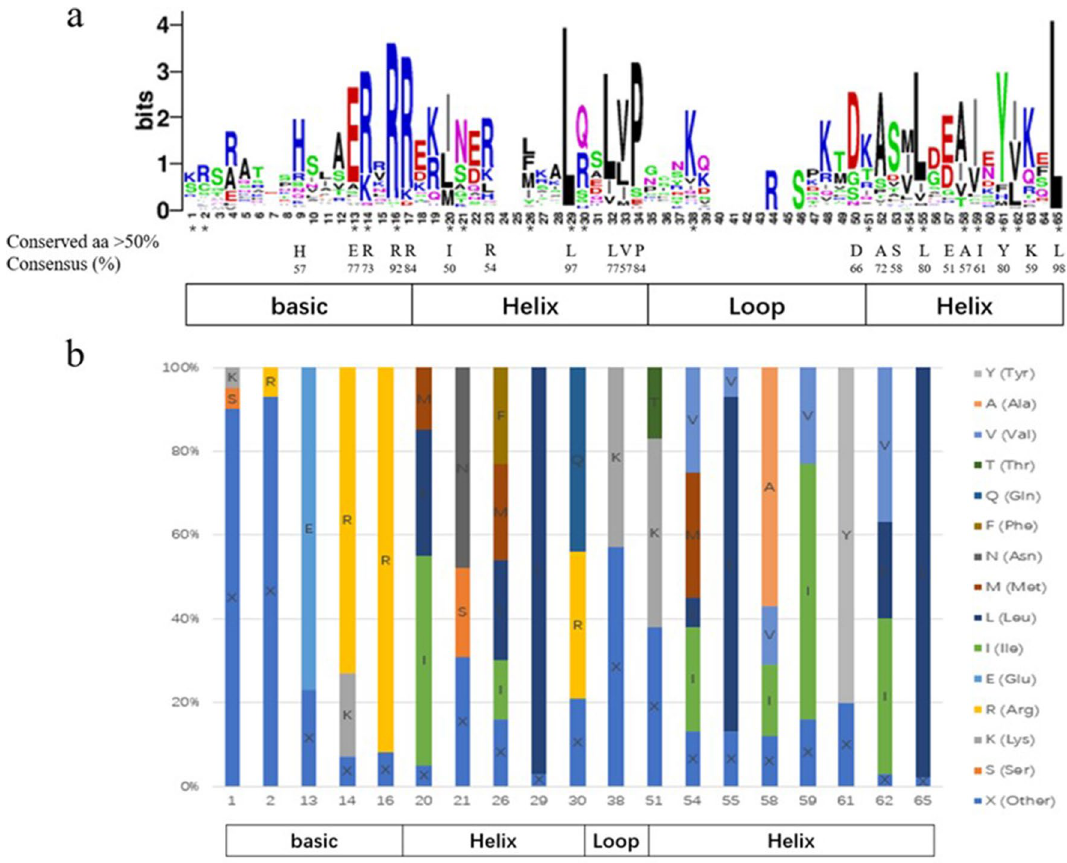
Figure 3. The characterization and distribution of bHLH domains across all VdbHLH. (a) The sequence logo of the bHLH domain. The asterisks represent the 19 conserved amino acids mentioned previously by Atchley. The capital letters represent conserved amino acids that contain more than 50%. ( b ) The distribution of amino acids in the bHLH domain. The columns of different colors represent the percentage of amino acids at this